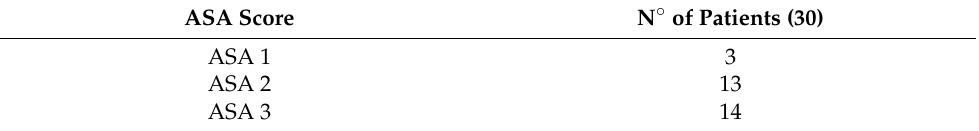
Table 3. ASA risk